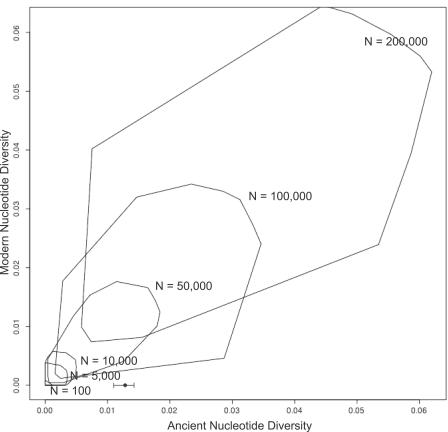
The Observed Ancient and Modern Diversity Plotted below (•) with Standard Error Bars Shows the Rejection of the Null Model of a Constant Population with Sizes Ranging from 100 to 200,000 for the Modern and Ancient Nucleotide Diversity in C. sociabilis Found in Cueva TrafulThe 95% confidence hulls at each population size assume a single panmictic population based on 1,000 iterations of Serial Simcoal [4] for modern and ancient nucleotide diversity.